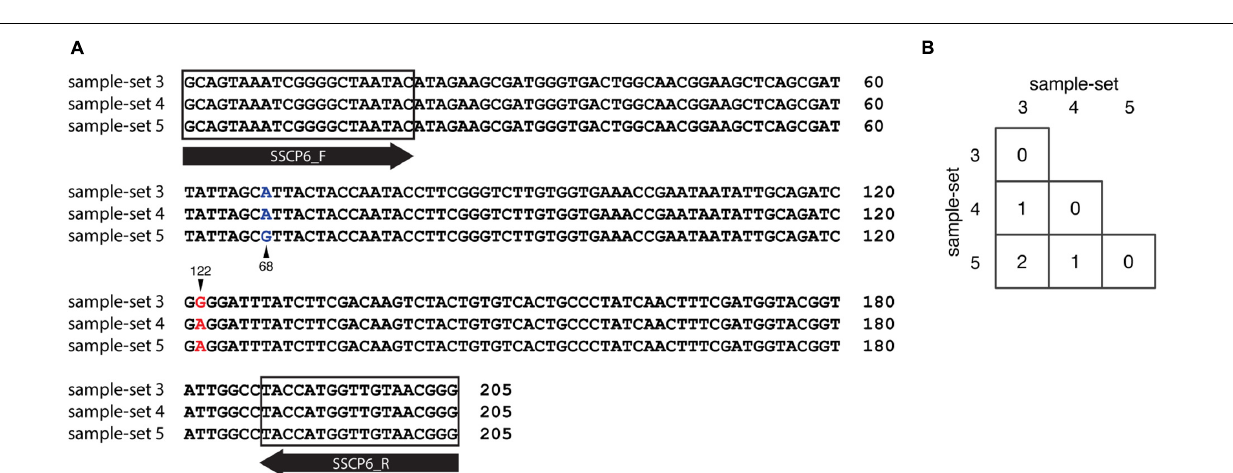
FIGURE 6 | The single-strand conformation polymorphism (SSCP) fingerprint of sample-sets 3 and 4 presented in the separated clusters. The left-hand panel illustrates the dendrogram with the similarity score of the fingerprint patterns. The dendrogram separated the SSCP fingerprint patterns of sample-set 3 (orange) from sample-set 4 (purple).